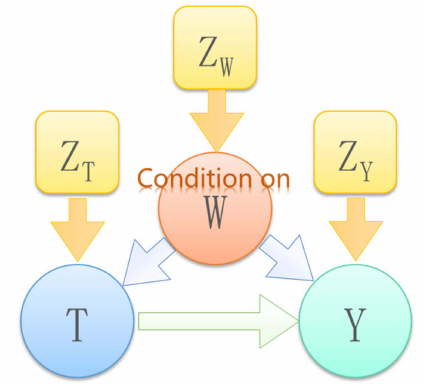
Figure 6. Adjustment formula application